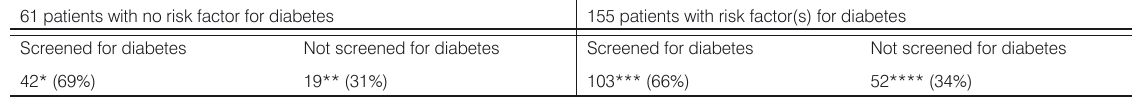
Table 1. Prenatal screening for diabetes in 216 cases that resulted in Neurological birth injuries following shoulder dystocia.